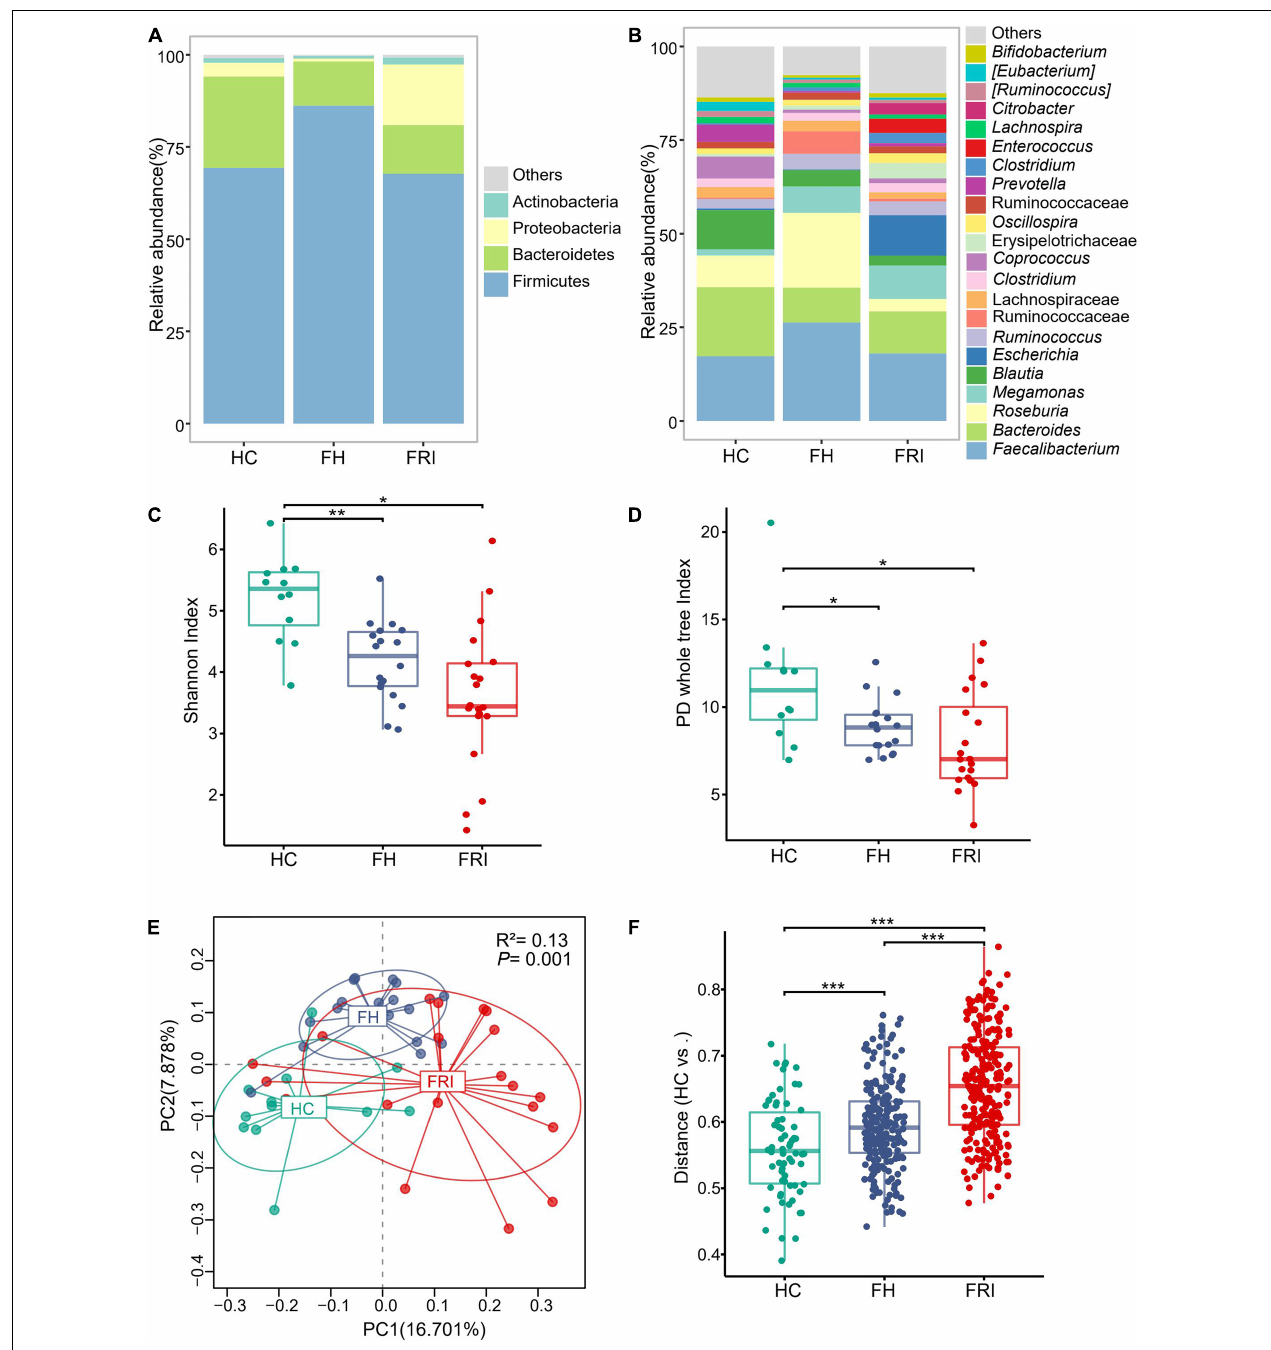
FIGURE 1 | The gut microbiota composition in fracture-related infection (FRI), fracture healed (FH), and healthy controls (HC) groups. (A) Taxonomy composition at the phylum level. (B) Taxonomy composition at the genus level. (C) α Diversity indicted by Shannon’s diversity index. (D) α Diversity indicated by PD whole tree index. (E) Principal coordinate analysis (PCoA) based on Unweighted UniFrac distance. (F) Comparisons of β diversity indicated by Unweighted UniFrac distance between samples in HC group and each group. “Others” represents lower-abundance taxa. * P < 0.05, ** P < 0.01, and *** P < 0.001.